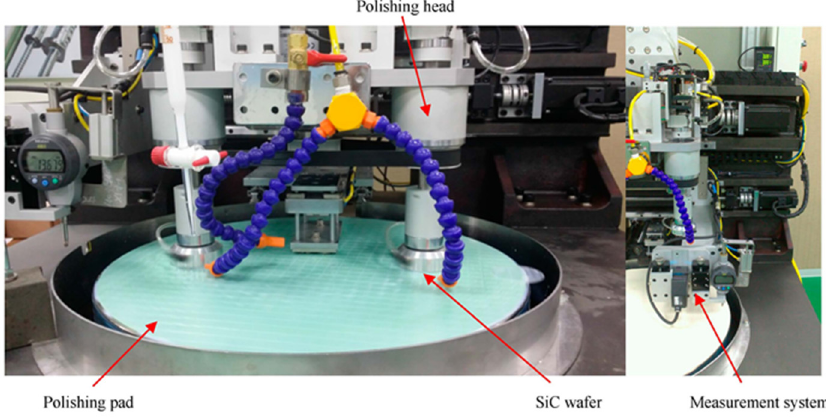
Figure 2. Experimental setup for the polishing system used in this work.